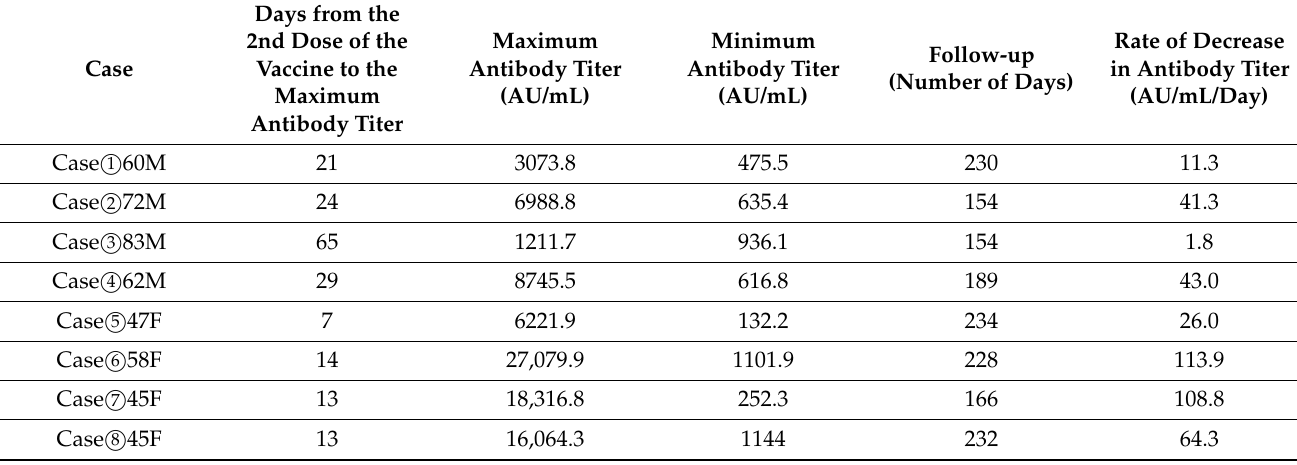
Table 3. Eight cases with multiple follow-ups after the second dose of